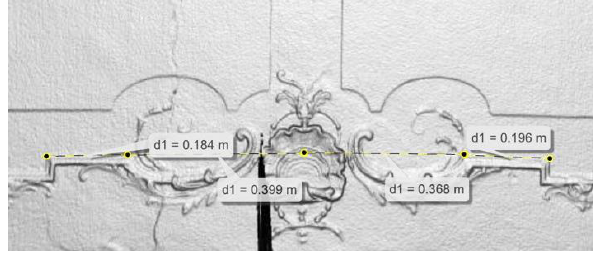
Figure 4. Measurement of stucco ornaments on laser scanner white-meshed